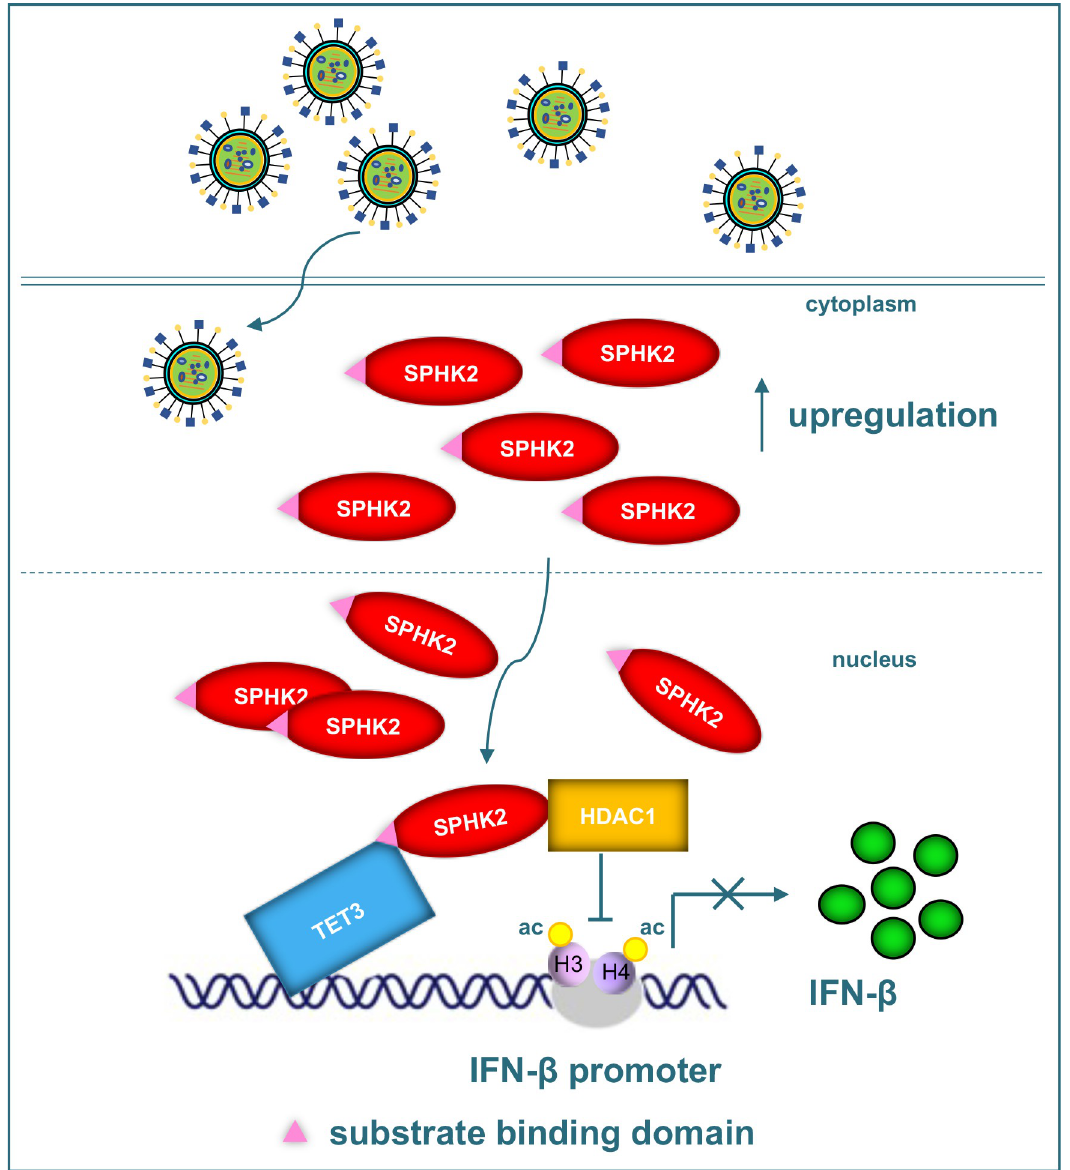
Fig 9. SPHK2 interacts with HDAC1 and TET3 to inhibit IFN- β transcription. The expression of SPHK2 in IAV infected cells is upregulated and then the location of SPHK2 is shifted from cytoplasm to nucleus. Afterwards, SPHK2 accumulated in the nucleus interacts with HDAC1 and its substrate binding domain also interacts with TET3 that bands to IFN- β promoter. Therefore, HDAC1 is recruited to IFN- β promoter and inhibited IFN- β transcription by enhancing the deacetylation of IFN- β